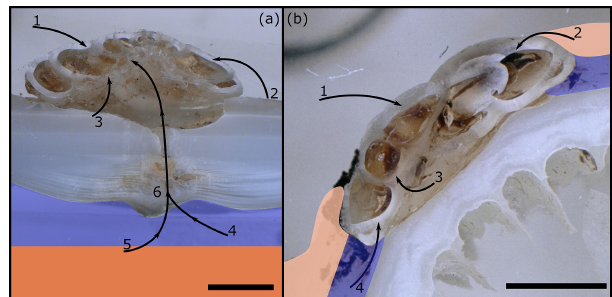
Figure 6. Possible pathways of E / Ca and isotopic signals into the foraminiferal calcite. (a) H. sarcophaga on A. excavata , (b) H. sar- cophaga on D. pertusum. Blue areas represent the calcifying space, and orange areas represent mantle tissue in A. excavata (a) and or- ganic layer (coenosarc/mucus) in D. pertusum (b) . Uptake of sea- water and free-floating particles (1), ingestion of host organic mate- rial (periostracum, coral tissue/mucus) (2), ingestion of dissolved carbonate material (3), ingestion of extracellular calcifying fluid (ECF) (4), ingestion of Mantle tissue (5), and ingestion of carbon- ate and organic material from the deposited callus (6). Scale bar is 100µm. Please note that the calcifying space and organic layers are displayed enlarged for improved visibility. Actual size of the cal- cifying space amounts to 1–100nm (Nakahara, 1991; Tambutté et al., 2007). The organic layer (coenosarc) is ∼ 25µm in thickness (Tambutté et al.,